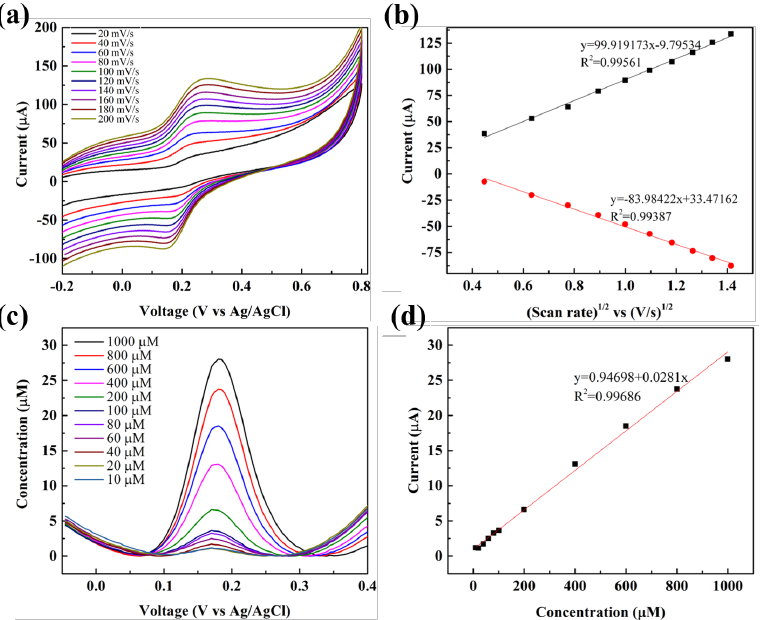
Figure 8. ( a ) CV curves obtained at different scan rates (20–200 mV/s) using BT/rGO for oxidation of dopamine (500 µM). ( b ) Calibration plots featuring the anodic (I pa ) and cathodic peak currents (I pc ) as a function of the square root of the scan rate. ( c ) DPV current responses for dopamine (10–1000 µM) in PBS (0.1 M, pH 7.03), and the ( d ) peak current–dopamine concentration